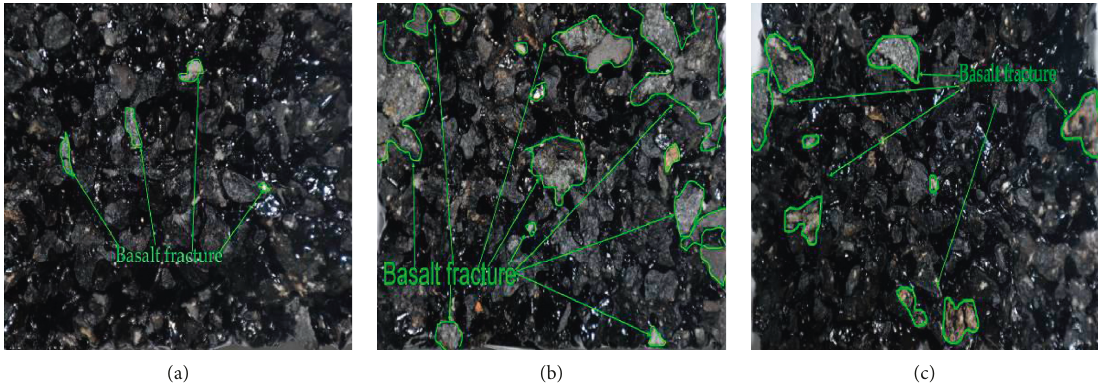
Figure 14: Typical sections of no-fiber samples. (a) 5 ° C. (b) − 5 ° C. (c) − 15 ° C.